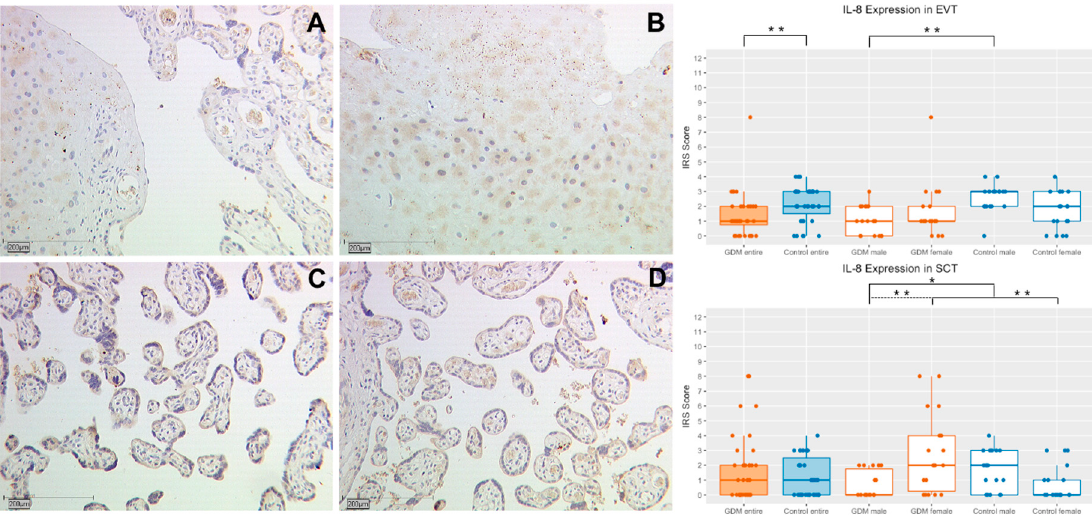
Figure 2. Representative immunohistochemical staining for IL-8 in EVT in placentas of women with GDM and the control group at a magnification of 10×. Staining of the EVT in a placenta affected by GDM ( A ) and of the control group ( B ). IL-8 expression of the SCT in placentas with GDM is demonstrated in image ( C ) and of the control group in image ( D ). The quantification of the IL-8 expression in placentas (with use of the IRS) of the study and control group and also their subgroups is shown in the box plots. Orange boxes represent the GDM group and blue boxes the control group. The range within the boxes represents the values between the 25 th and 75 th percentile with a horizontal line at the median. The T-bars extend 1.5 times of the interquartile range, or if no value is in that range, to the minimum or maximum value. The dots are marking the value of each data point. Significant results are linked with continuous or dashed lines and marked with an asterisk ( p < 0.05: *; p < 0.01: **).